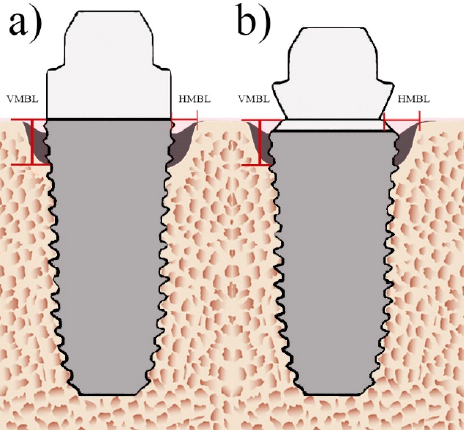
Figure 2. Radiographic measurements of platform-switched implants. ( a ) Platform-matched (PM) dental implants, ( b ) platform-switched (PS) dental implants. Vertical marginal bone loss, VMBL; horizontal marginal bone loss, HMBL .